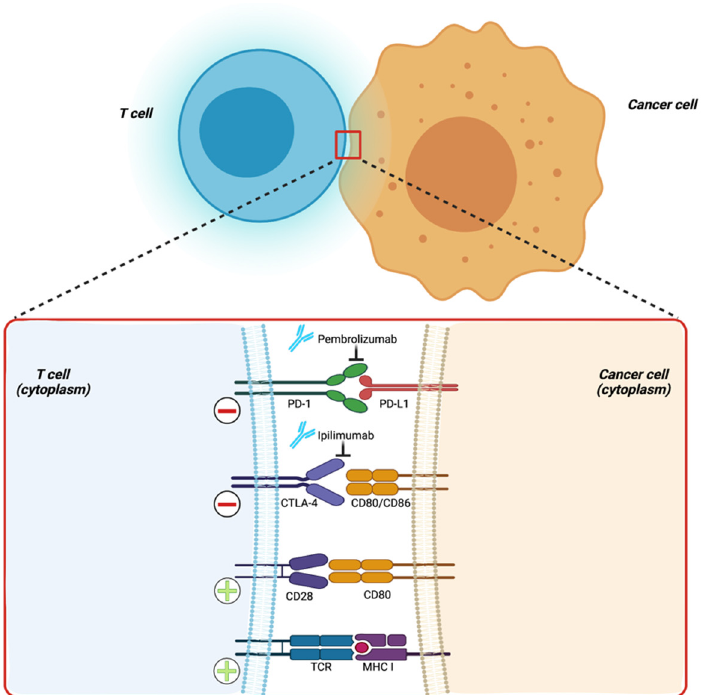
Figure 2. Main immune checkpoints acting on cancer cell recognition by effector immune cells. PD-1: programmed death-1; PD-L1: programmed death ligand 1; CTLA-4: cytotoxic T-lymphocyte antigen 4; TCR: T-cell receptor; MHC I: major histocompatibility complex I; + (plus sign): activating signal; − (minus sign): inhibitory signal. Created with BioRender.com (accessed on 14 July 2021).